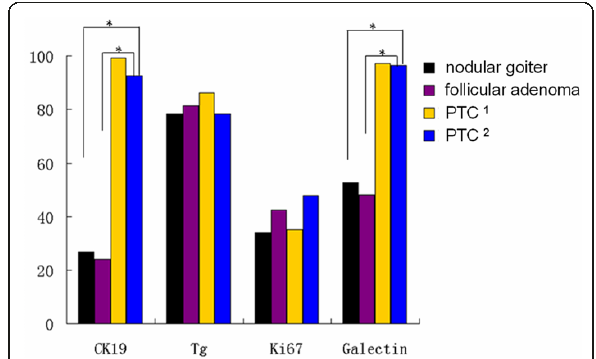
Figure 2 CK19, TG, Ki67 and galectin-3 positive rate in nodular goiter, follicular adenoma, papillary thyroid carcinoma without lymphatic metastasis and papillary thyroid carcinoma with lymphatic metastasis . PTC 1 : papillary thyroid carcinoma (PTC) without lymphatic metastasis; PTC 2 : papillary thyroid carcinoma (PTC) with lymphatic metastasis.